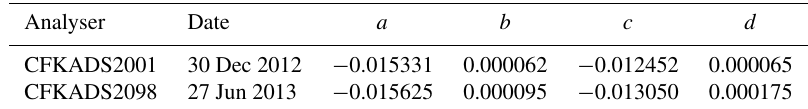
Table 4. Water vapour correction coefficients for the WCC-Empa travelling CRDS instruments; coefficients a and b refer to the correction of CO 2 , while c and d refer to CH 4 (see Eqs. 1 and 2).